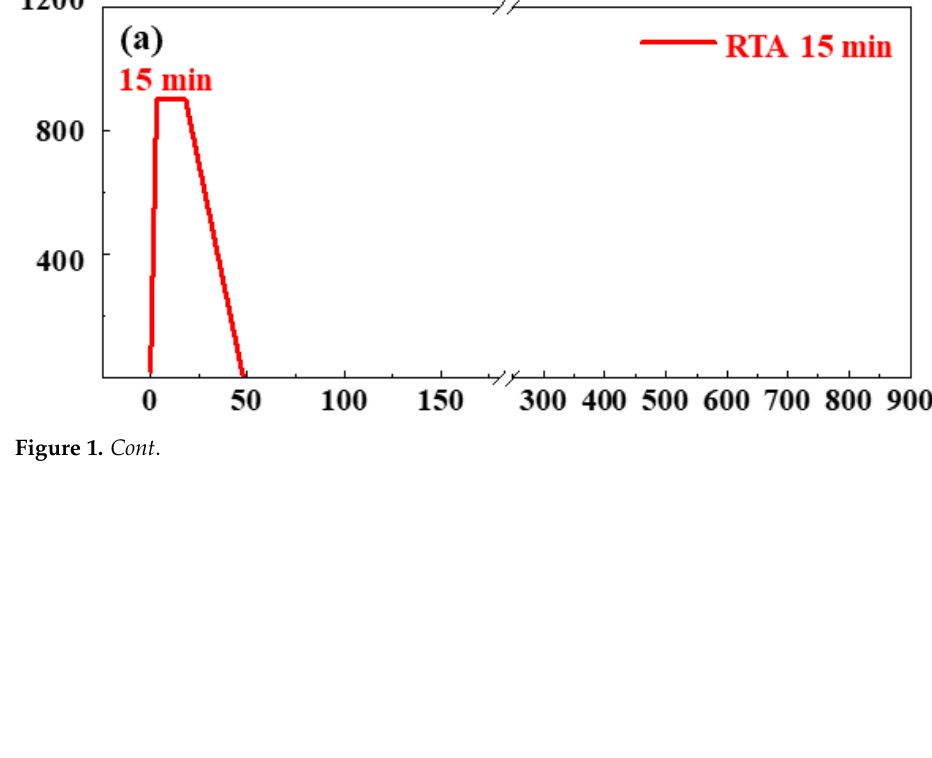
Figure 1. Schematic diagram of β -Ga 2 O 3 thin film annealing method applied with various processes. ( a ) RTA 15 min, ( b ) furnace 2 h + RTA 15 min, ( c ) furnace 2 h, ( d ) furnace 4 h. Figure 2 displays the XRD pattern of the β -Ga 2 O 3 thin film annealed by a thermal furnace at the various temperatures of 500, 600, 700, 800, and 900 °C. After the spin-coating